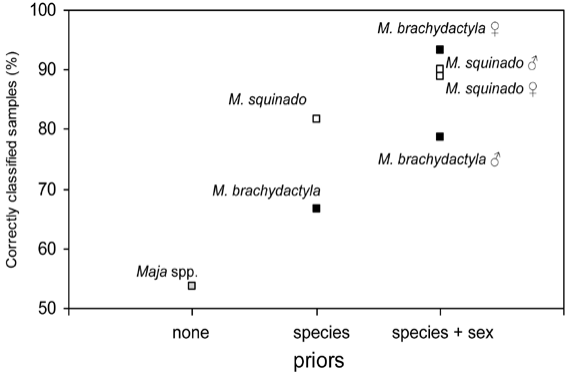
Fig. 4. – Performance of discriminant analysis based on δ 13 C and δ 15 N without any prior information, incorporating species identity, and incorporating species and